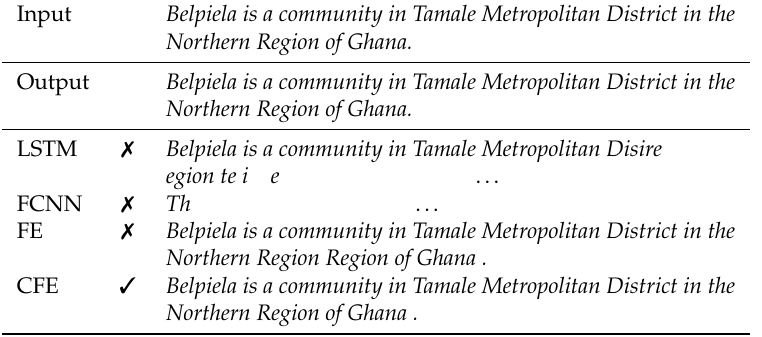
Table 10. Predictions obtained by the four different models for a selected sample case in the experiment E2. Only the output obtained by CFE is